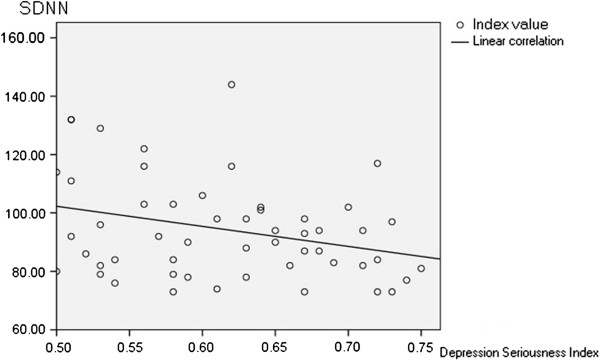
The correlation between Depressive severity index and SDNN. Pearson relativity analysis shows a negative correlation between depressive severity index and SDNN (P<.05; r = −.298).